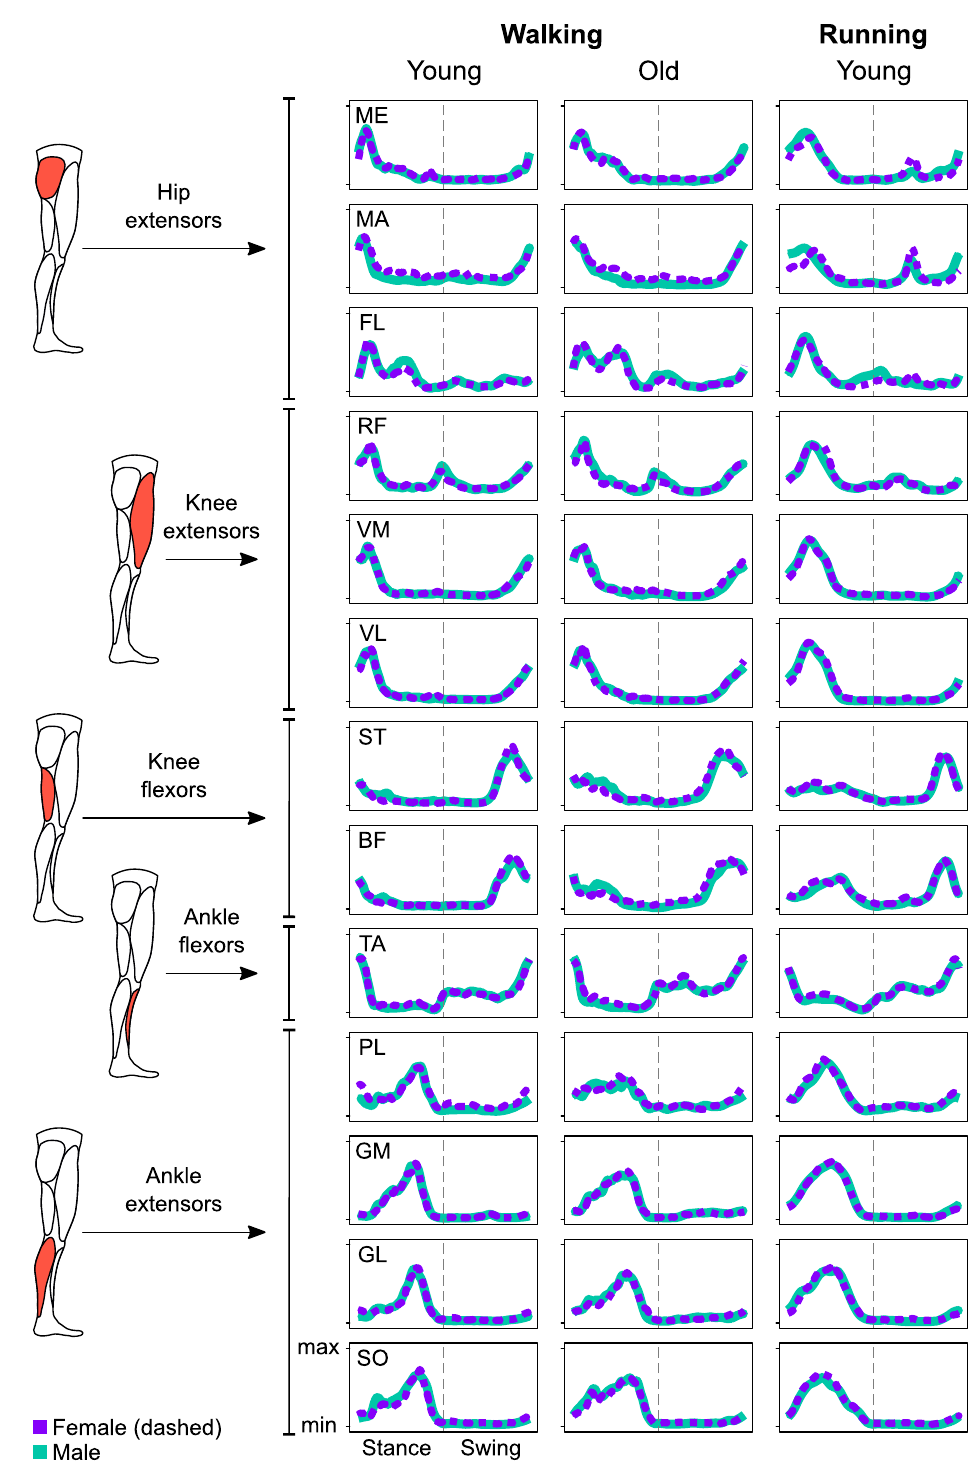
Fig 3. Average muscle activity. The mean activations of the recorded muscles are presented for the stance and swing phases of walking (young and old adults) and running (young adults) for female and male participants. Signals were rectified, filtered, time- and amplitude normalized as described in the methods. Muscle abbreviations: ME = gluteus medius, MA = gluteus maximus, FL = tensor fasciæ latæ, RF = rectus femoris, VM = vastus medialis, VL = vastus lateralis, ST = semitendinosus, BF = biceps femoris, TA = tibialis anterior, PL = peroneus longus, GM = gastrocnemius medialis, GL = gastrocnemius lateralis, SO = soleus.